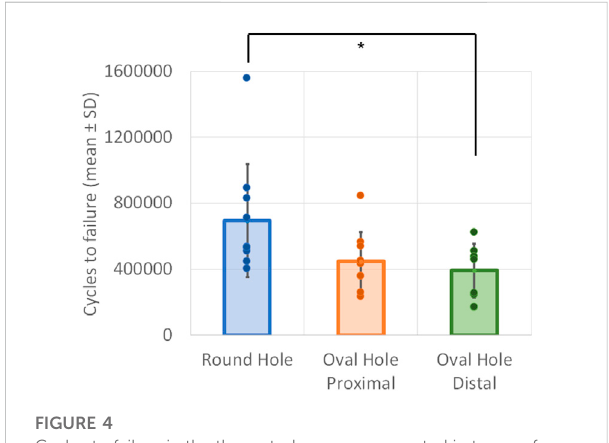
FIGURE 4 Cycles to failure in the three study groups presented in terms of mean value and SD. Circular points indicate cycles to failure for individual specimens. Star shows signi fi cant difference.